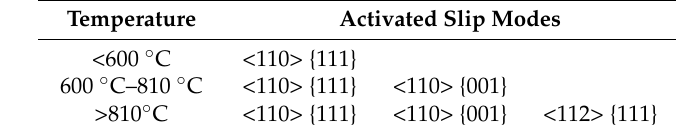
Table 4. Slip systems activated at different temperature for DD6 superalloy.